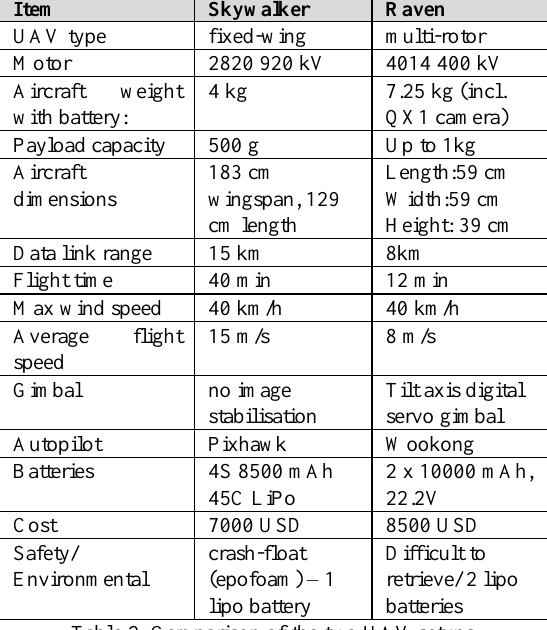
Table 2. Comparison of the two UAV setups